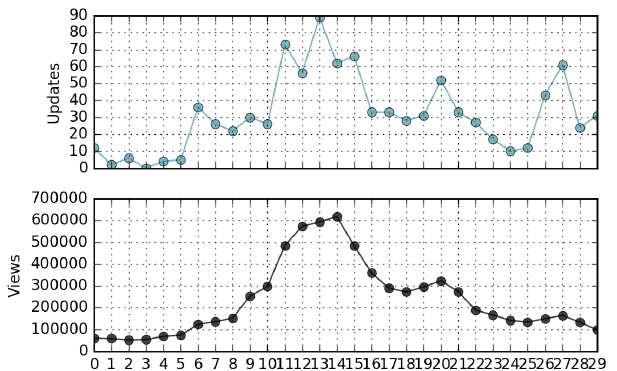
Figure 10. Views and updates of a popular movie page (“Deadpool”) in February 2016, from 1 February to 1 March.